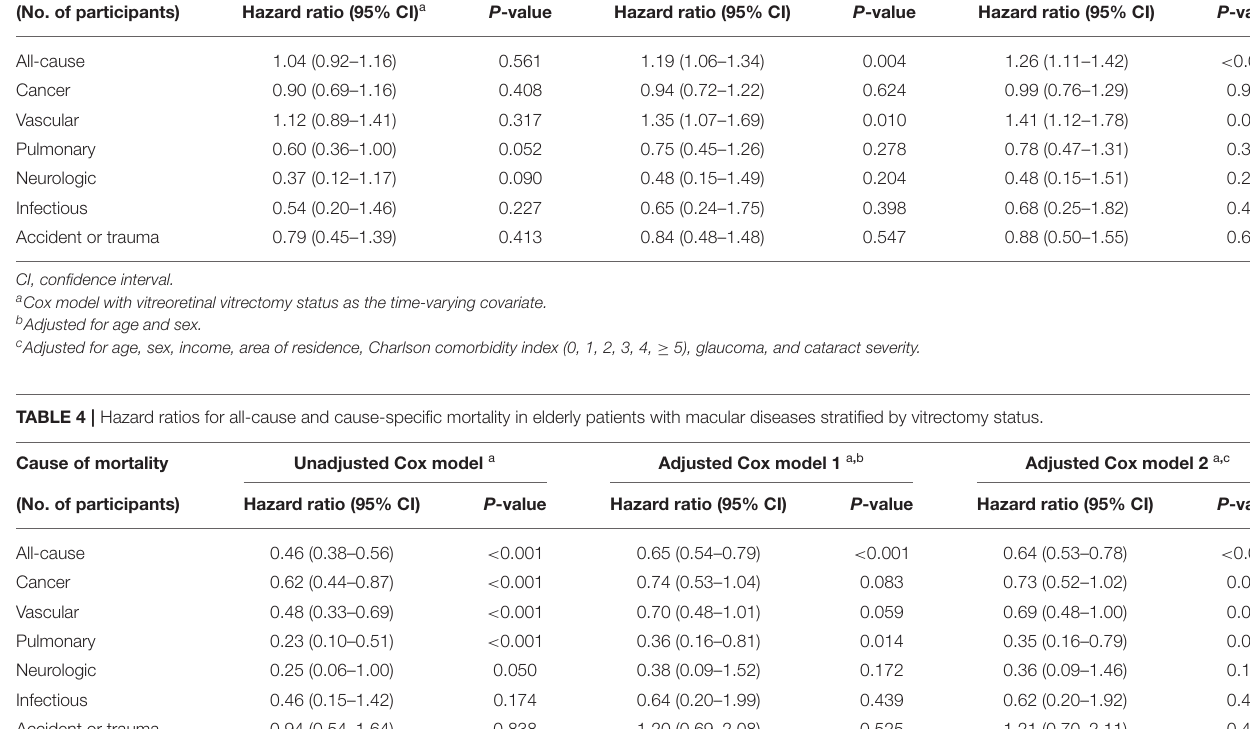
TABLE 3 | Hazard ratios for all-cause and cause-specific mortality in elderly patients with retinal vascular diseases stratified by vitrectomy status. Cause of mortality